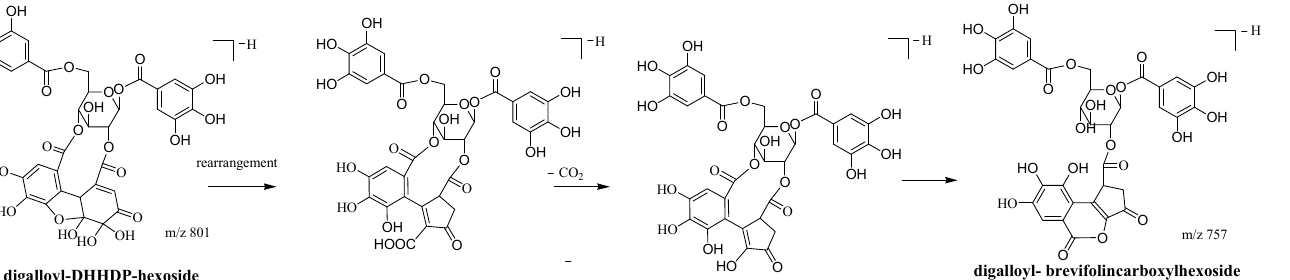
Figure 3. Rearrangement and decarboxylation of DHHDP moiety in digalloyl-DHHDP-hexoside (illustrated by 1,6- O -digalloyl-2,4- O -DHHDP- β - D -glucoside).